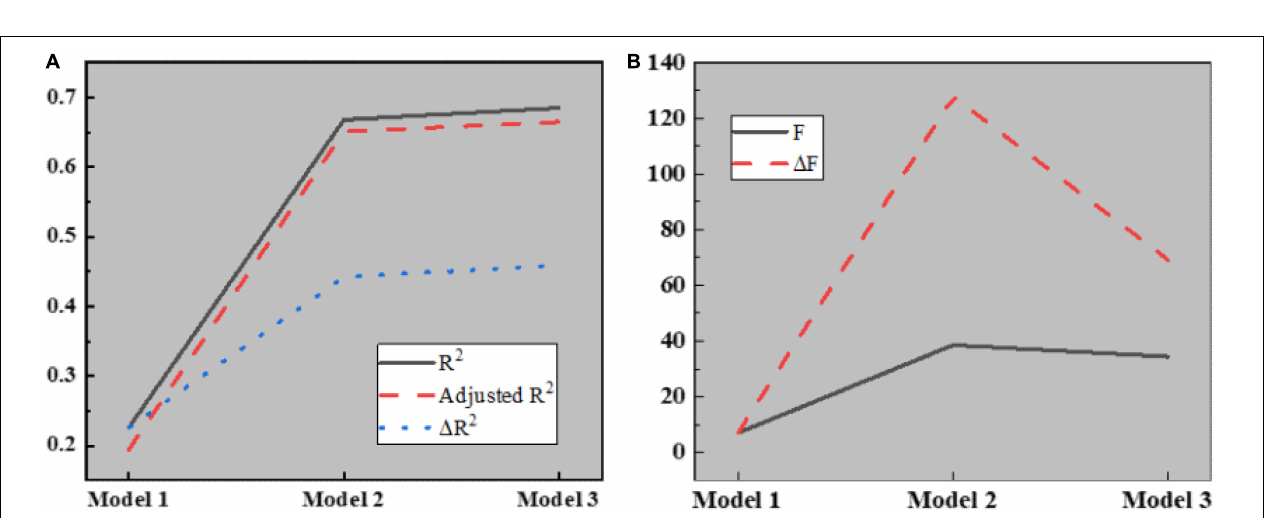
FIGURE 12 | Parameters in regression analysis. (A) Parameters of R 2 ; (B) Parameters of